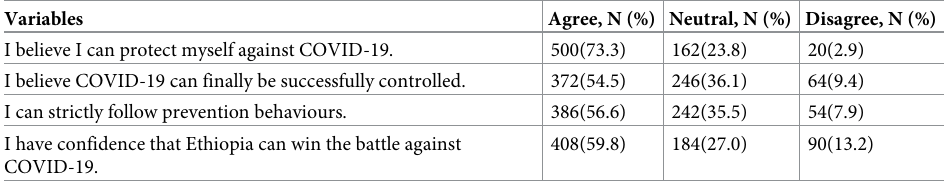
Table 5. Perceived self-efficacy in controlling COVID-19 among DBU students, 2020.